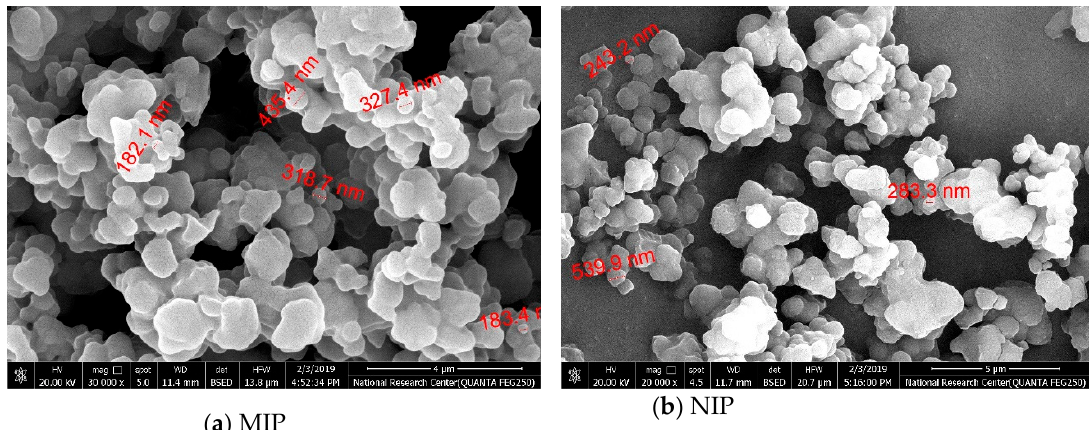
Figure 2. Fourier Transform-Infrared (FT-IR) spectra for ( a ) NaDC, ( b ) NaDC/MIP, ( c ) washed MIP and ( d ) NIP beads.